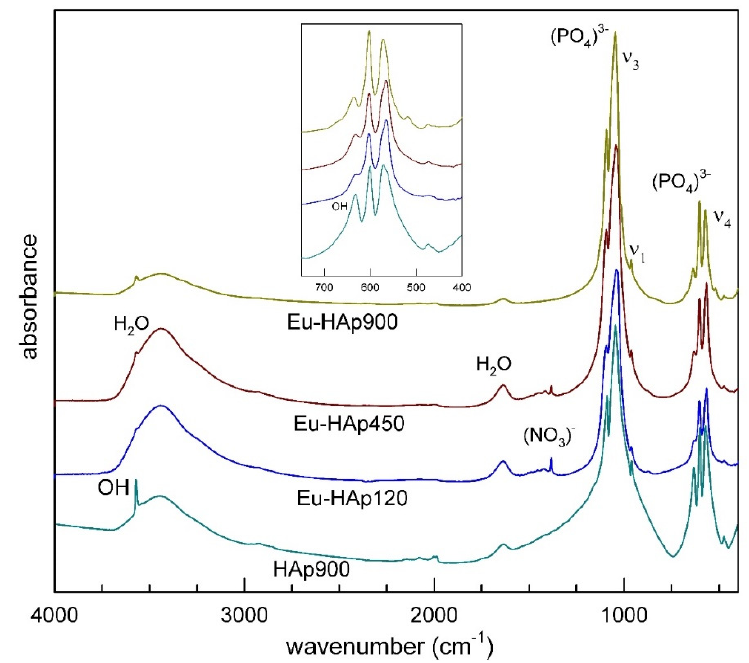
Figure 4. FTIR spectra of Eu-doped HAp samples in comparison with undoped HAp. Table 6. Measured absorption in the FTIR spectra and relative assignments for HAp samples. Vw = very weak, w = weak, sh =